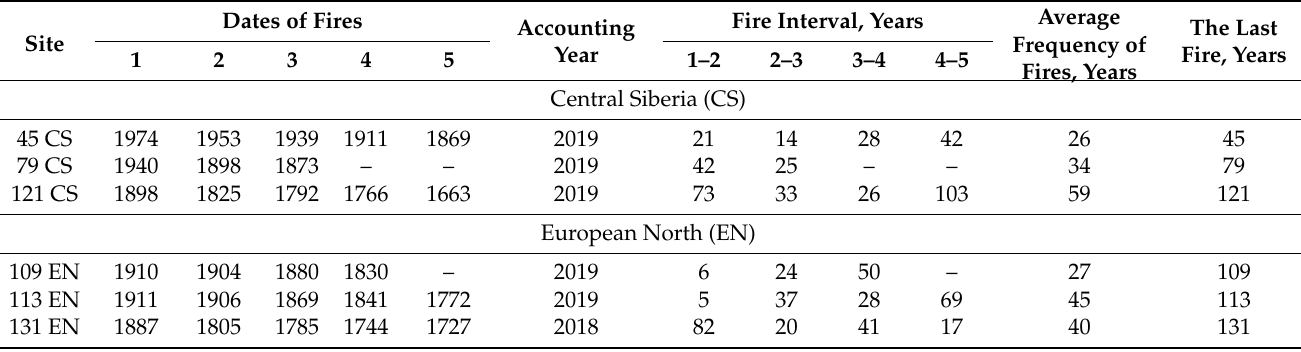
Table 2. Dates of fires with a fire period for the objects under